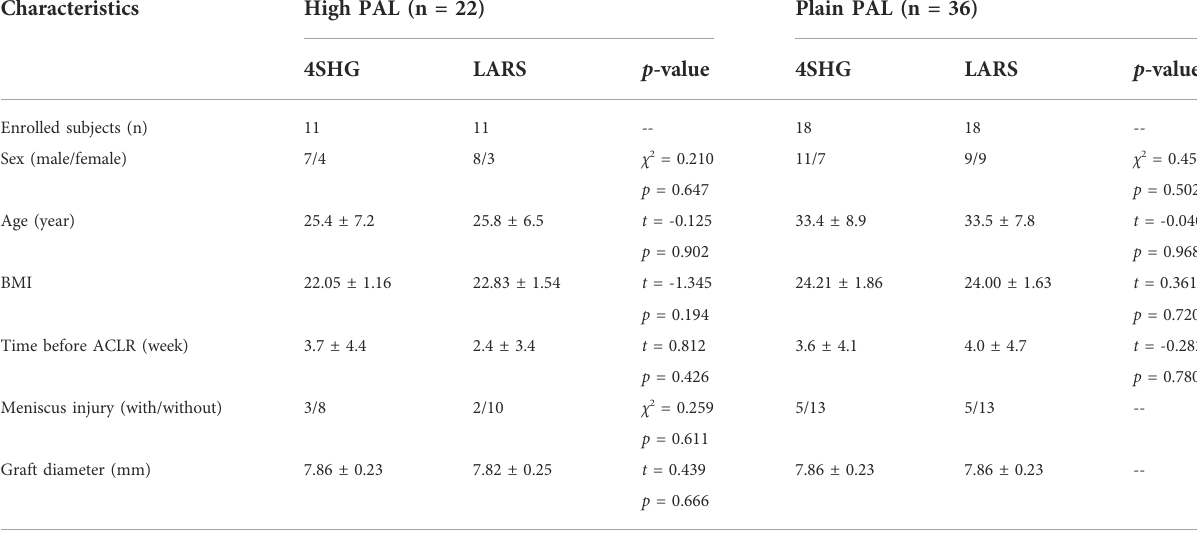
TABLE 1 Basic characteristics of the 4SHG and LARS subgroups in patients with different PALs.